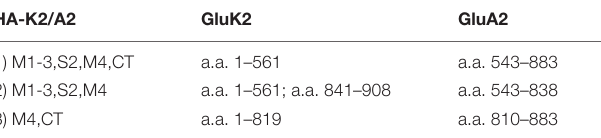
TABLE 1 | Synapse differentiation-induced gene 4 (SD4)/IFITM3 chimeras. HA-IFITM3/SD4